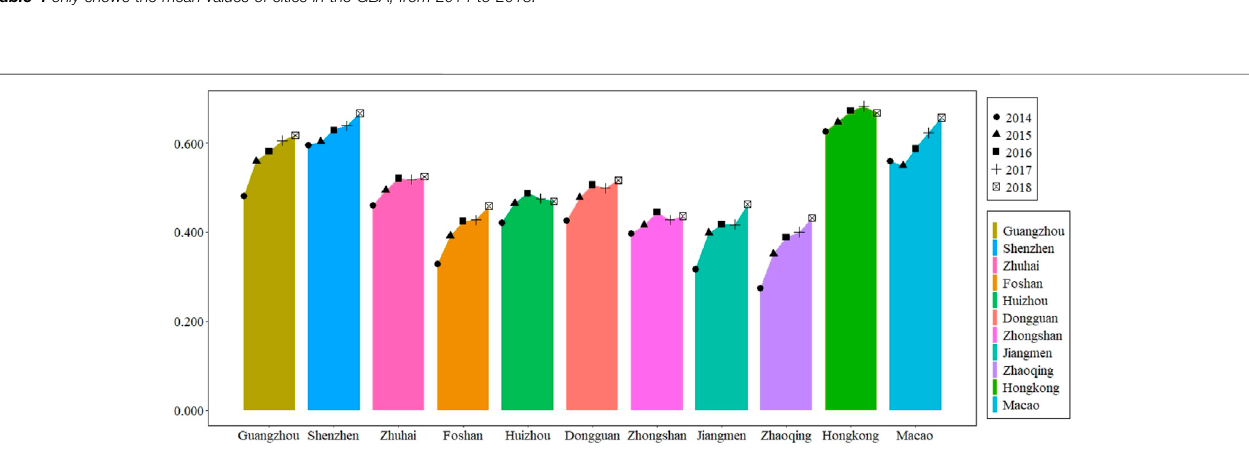
Table 4 only shows the mean values of cities in the GBA, from 2014 to 2018.